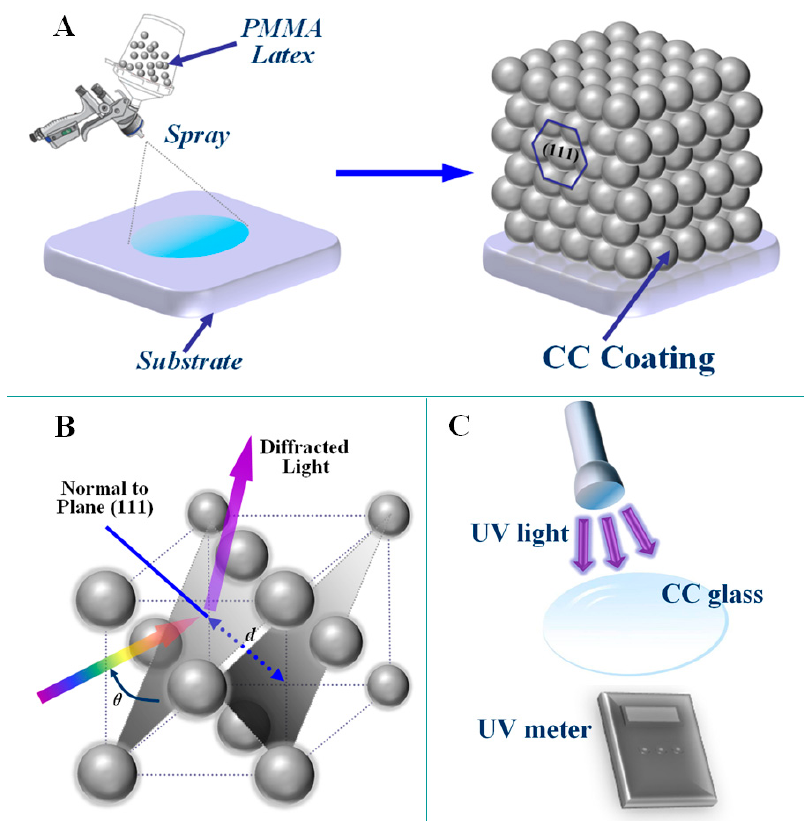
Figure 1. Illustration of the: ( A ) construction of PMMA CC; ( B ) Bragg diffraction of the CC and ( C ) UV shielding test of CC coated glasses.